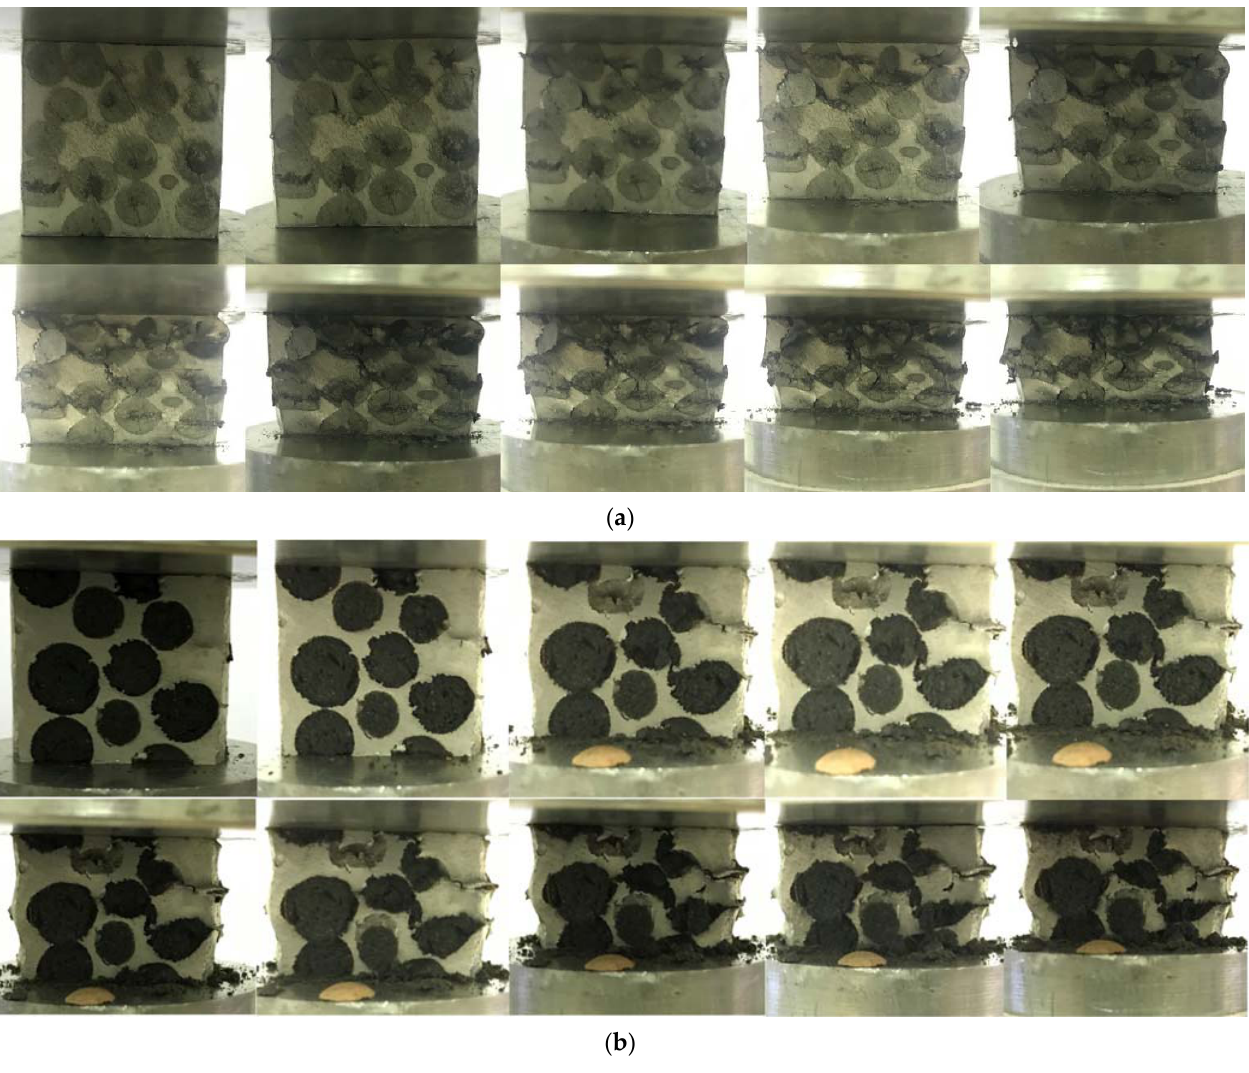
Figure 8. Deformation sequence from 0% strain in 5% steps from top left to right and down: ( a ) Al-EAn and ( b ) Al-ECn.